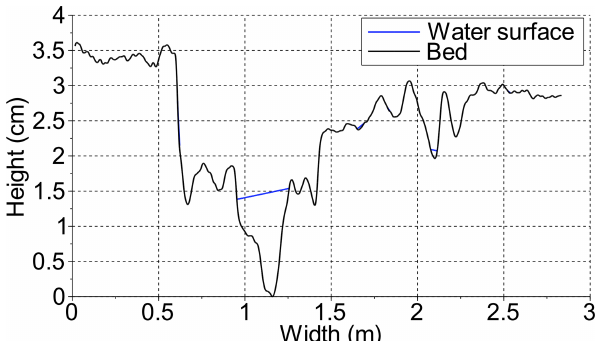
Figure 6. Example of water surface detection. In the cross section, we assume a straight line between the first water point (i.e. the dif- ference is higher than the threshold) on the cross section and the first next dry point (i.e. the difference is lower than the threshold).